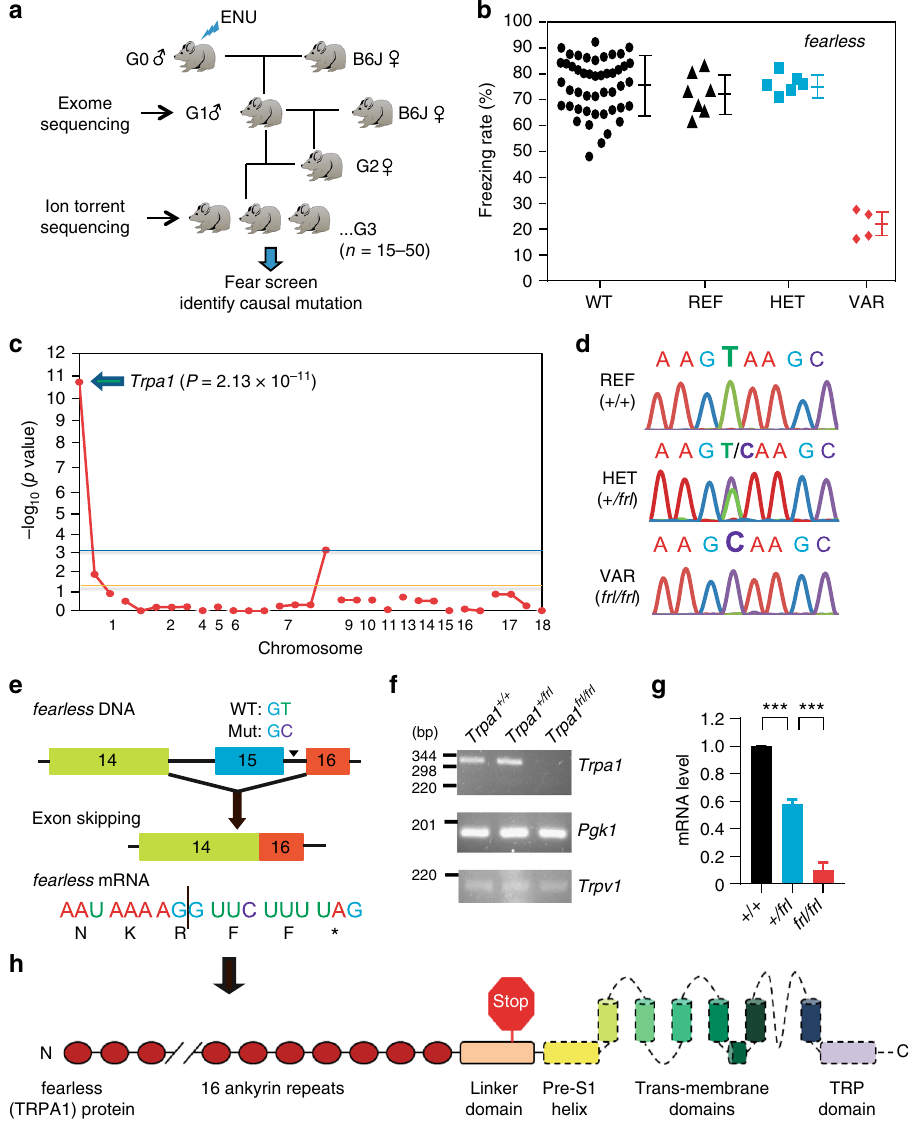
Fig. 2 Identi fi cation of fearless ( Trpa1 ) mutant mice by forward genetics screening. a A fl owchart of the recessive fear screen. b A graph of the fearless mutant pedigree consisting of seven reference (REF), six heterozygous (HET), and four phenovariant (VAR) individuals. A separate group of wild-type (WT) mice were included as controls every week. c A Manhattan plot showing a strong linkage ( P = 2.13 × 10 − 11 ) between the Trpa1 mutation and fearless phenotype. Horizontal yellow and blue lines represent the thresholds of P < 0.05 without or with Bonferroni correction, respectively. d The causative mutation was identi fi ed by sequencing the Trpa1 gene of REF, HET, and VAR mice. e A schematic of partial exon/intron structure of Trpa1 gene. The 5 ′ splice site (GT to GC) mutation results in the skipping of exon 15 and introduction of a premature stop codon. f , g Semi-quantitative ( f ) and quantitative ( g ) RT-PCR analysis showing that fearless mutant Trpa1 mRNA is diminished possibly owing to nonsense-mediated decay. Data are presented as mean ± SEM ( n = 4, Student ’ s t -test, *** P < 0.001). h A schematic of the domain structure of Trpa1 protein, with the stop sign marking the premature stop codon and dash line representing the domains missing in mutant Trpa1